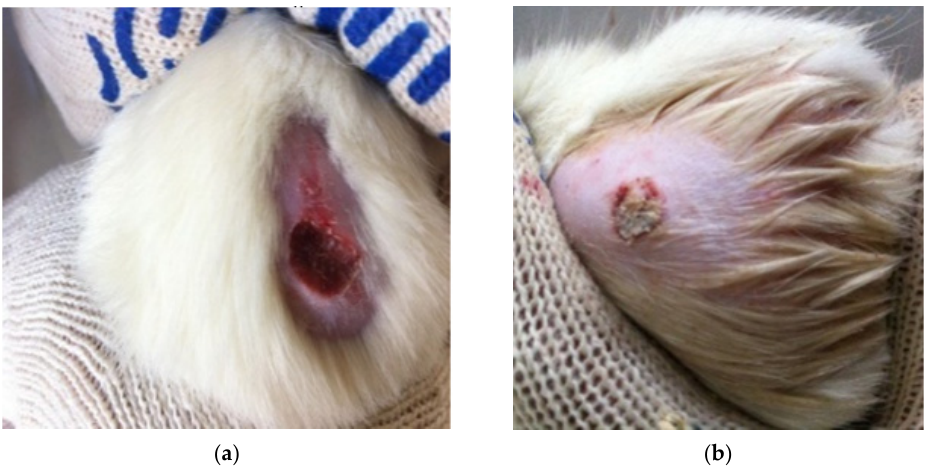
Figure 11. Photos of burn wounds of laboratory animals of group 1: ( a )—3rd day of the experiment, ( b )—10th day of the experiment.